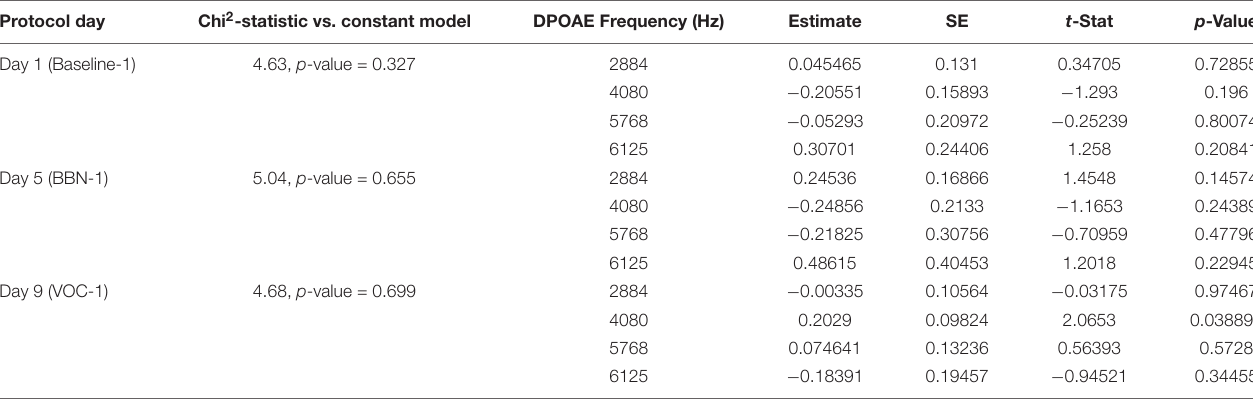
TABLE 2 | The generalized linear models evaluated the association between MOC reflex strength (DPOAE CAS-induced changes) and behavioral performance for late responses (3–5 s). Protocol day Chi 2 -statistic vs. constant model